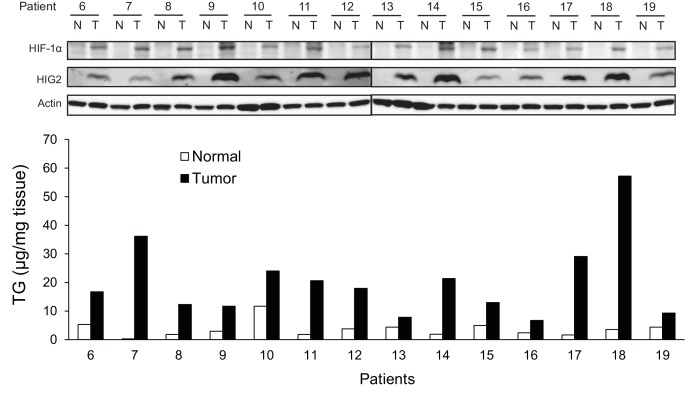
HIG2 expression is upregulated in human renal cell cancer tissues.Protein expression and TG content were examined in kidney tissues from human with renal cell cancer. T = kidney tumor, N = adjacent normal kidney tissue.